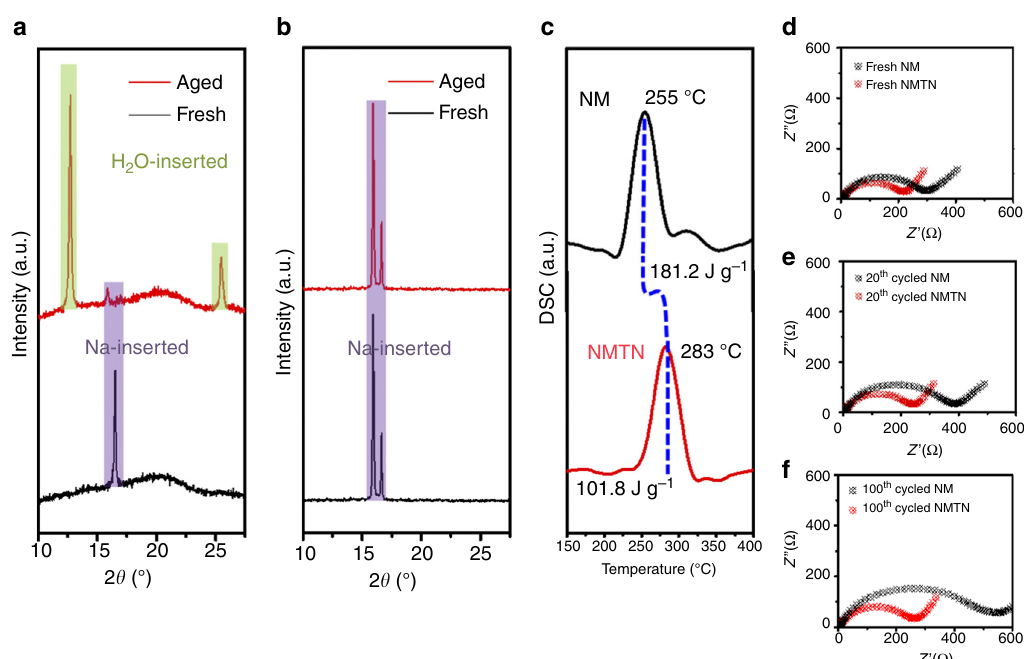
Fig. 3 Chemical/electrochemical/thermal stability of the NM and NMTN samples. a Structural evolution of the NM samples exposed to humid air for 3 days. The results show the phase transition process (O ′ 3-Birnessite) caused by H 2 O insertion; the vertical purple and yellow-green shadings indicate the Na-inserted and H 2 O-inserted layered structures, respectively. b Structural evolution of the NMTN samples exposed to humid air for 3 days. The results indicate a stabilized layered-structure independent of air exposure. c DSC results of the desodiated NM and desodiated NMTN electrodes. d – f Impedance evolution of the NM and NMTN electrodes during cycling. The results show the severely diminished electrochemical properties for the NM electrode and negligible electrochemical evolution of the NMTN